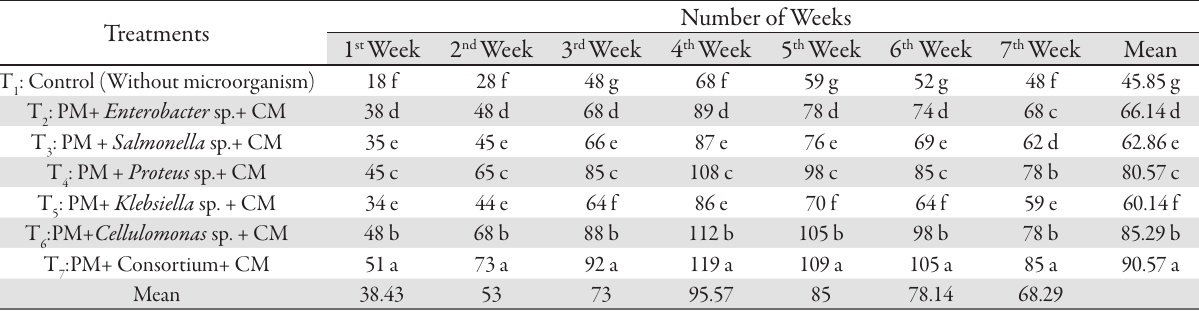
Tab. 6. Changes of bacterial population (CFU × 10 4 /g) during composting of Press mud with cattle manure Treatments